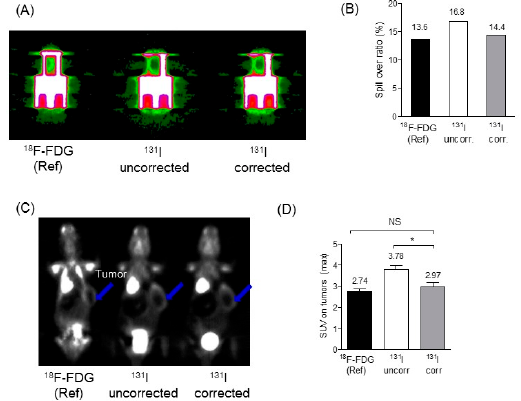
Figure 5. ( A ) Positron Emission Tomography (PET) image of NEMA image quality phantom, ( B ) spill-over ration of NEMA image quality phantom, ( C ) Representative PET data of mouse image, arrow sign indicates tumor region, ( D ) SUV in tumors, * p < 0.05.